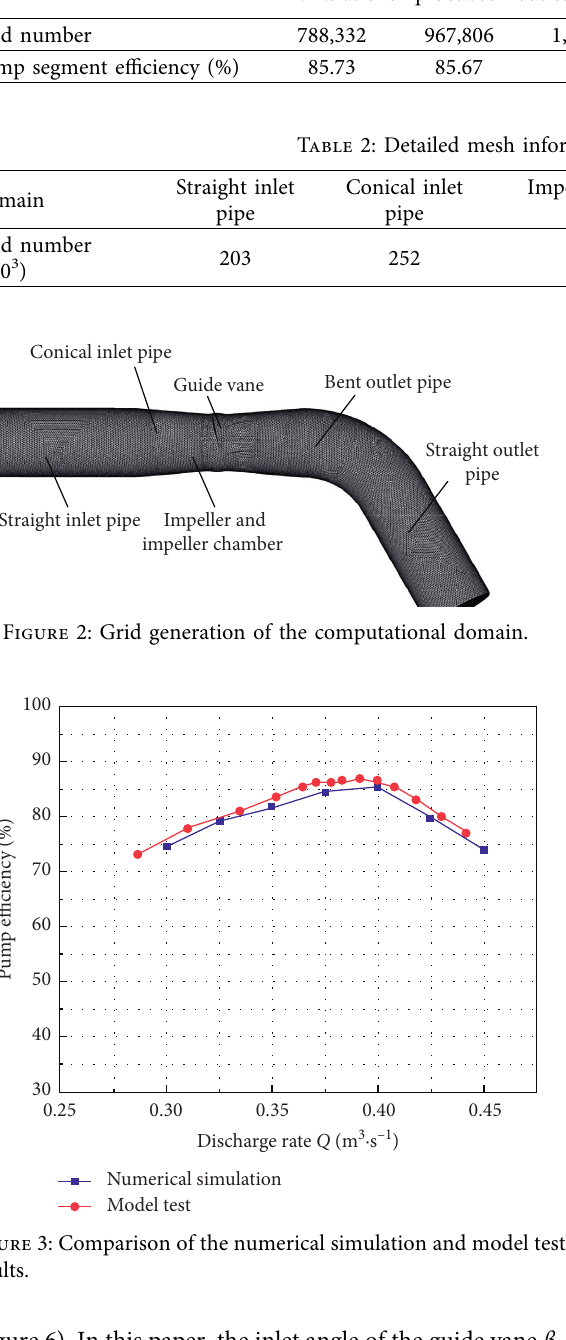
Table 1: Relationship between outlet conduit hydraulic loss and grid